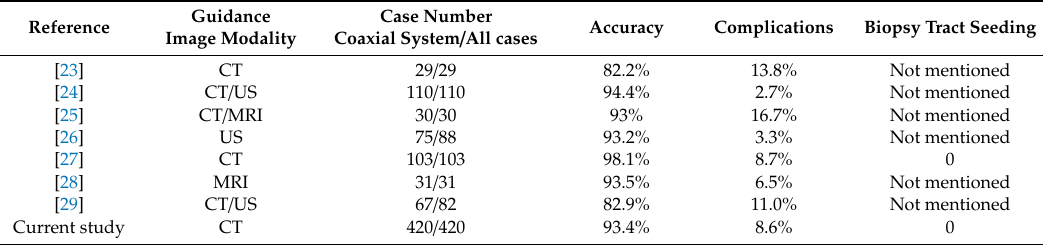
Table 6. Diagnostic accuracy and complication of percutaneous biopsy using coaxial needle